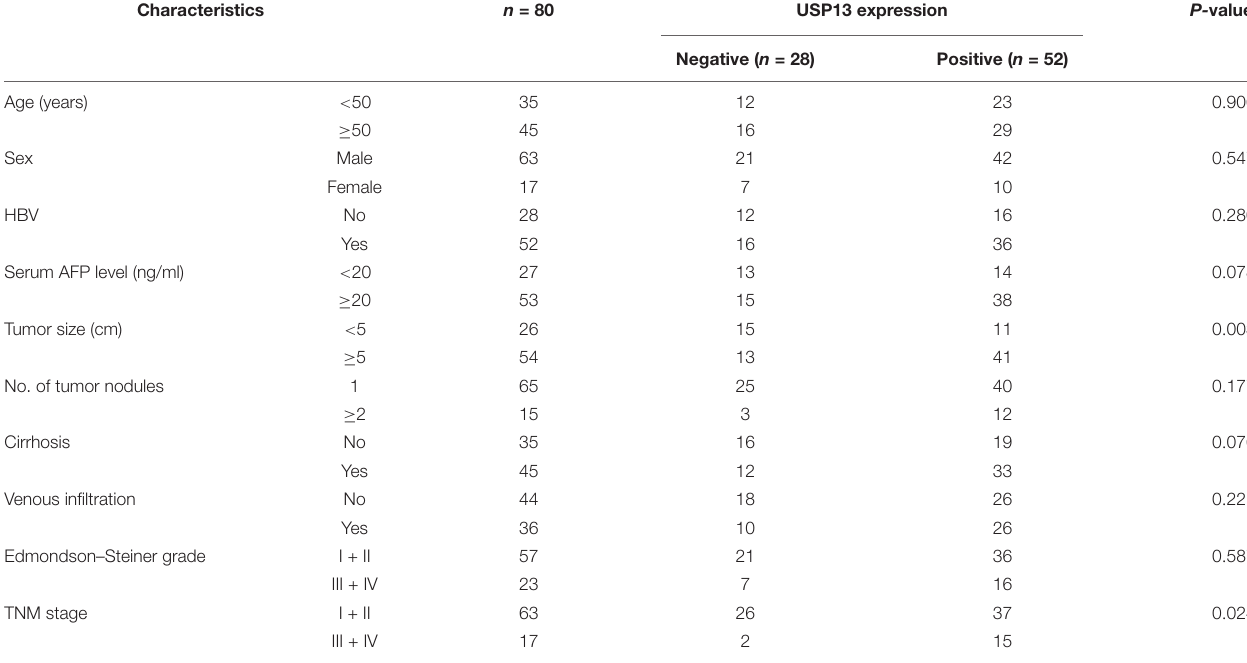
TABLE 1 | Correlation between USP13 expression and clinicopathologic characteristics of patients with hepatocellular carcinoma. Characteristics n = 80 USP13 expression P- value Negative ( n =